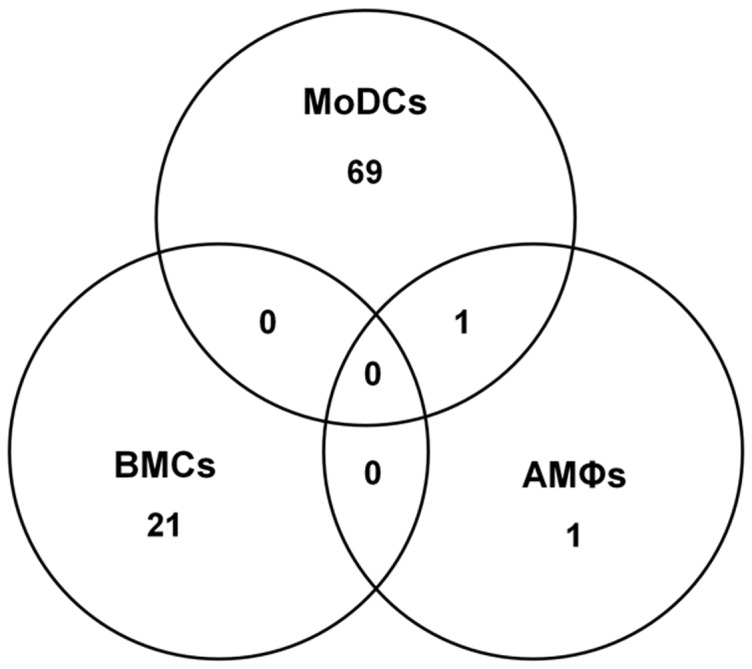
Transcriptome differences between immune cell subsets challenged with PCV2b.Venn diagram of differentially expressed genes after challenge with PCV2b is shown for each immune cell subset (P<0.05, −1.5≤ fold change ≥1.5).